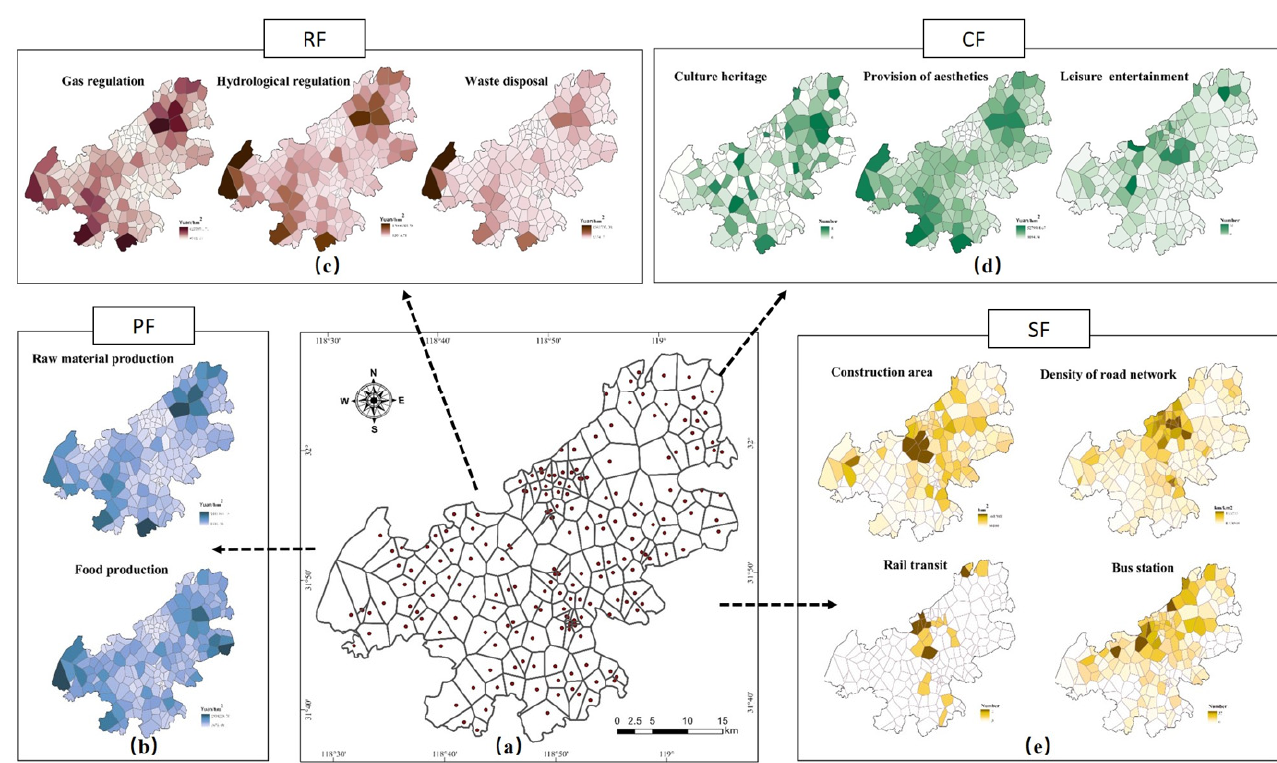
Figure 3. Spatial distribution characteristics of LFs in Jiangning District, Nanjing ( a ) the Tyson Polygon buffer of rural community ( b ) spatial distribution map of regulating function ( c ) spatial distribution map of Culture function ( d ) spatial distribution map of provision function ( e ) spatial distribution map of support function.